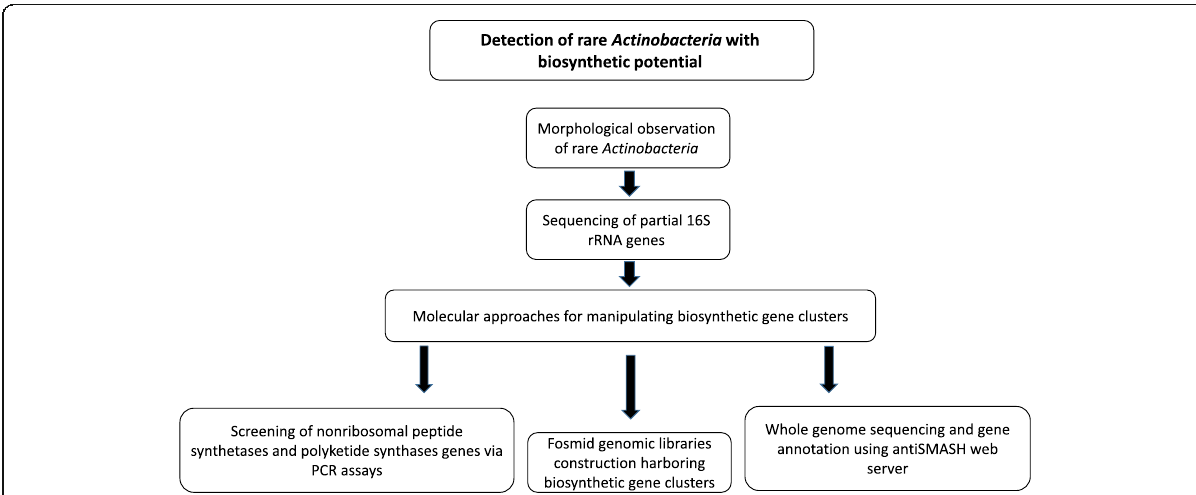
Fig. 1 Identification of bioactive rare Actinobacteria . The following flow chart demonstrates steps for the identification of Actinobacteria on the genus level and their biosynthetic genes. Additionally, it gives different options to manipulate these genes and hence monitor the biosynthetic capability of the